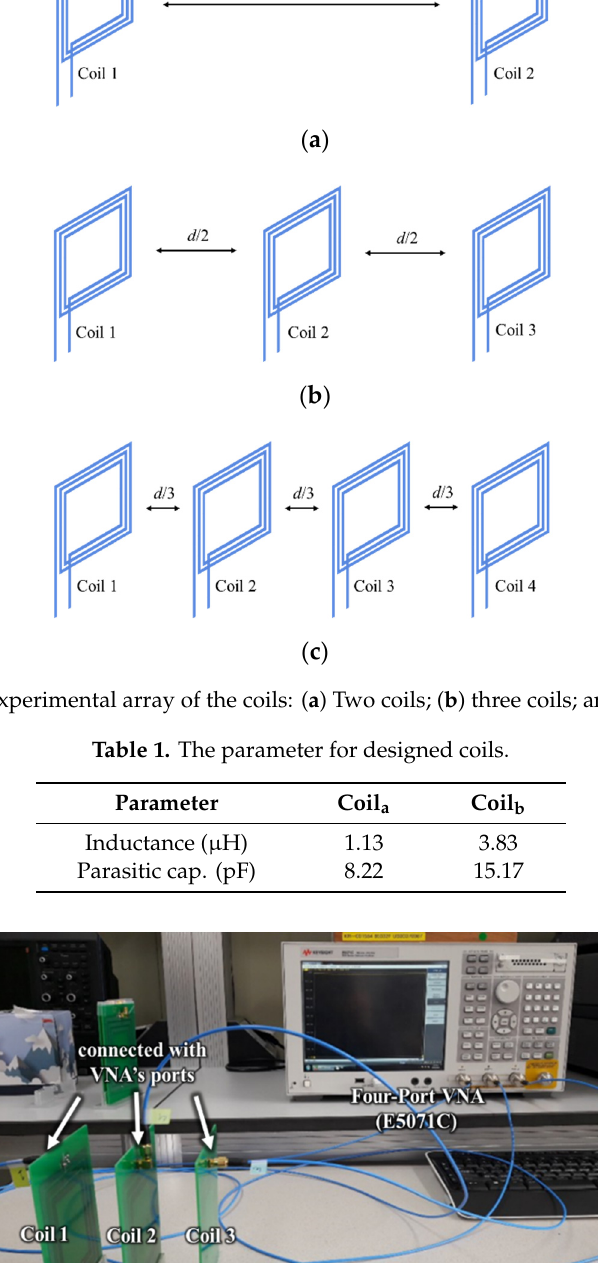
Figure 7. The experimental setup with a four-port vector network analyzer (VNA). Table 1. The parameter for designed coils.